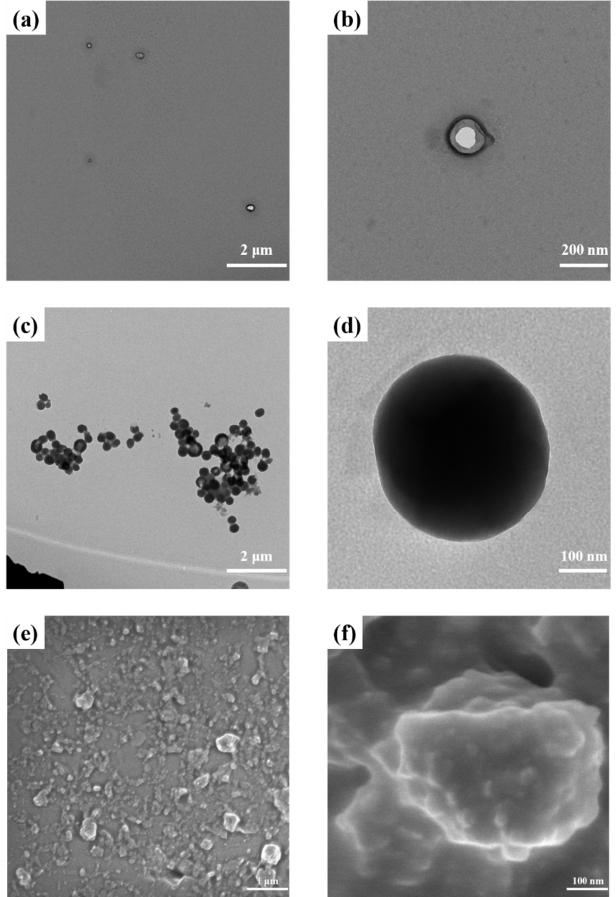
Figure 3. TEM and SEM images of the micelles: ( a ) TEM of PNI-U-DPy micelles; ( b ) TEM of PNI-U- DPy micelles (magnified); ( c ) TEM of PNI-C 60 micelles; ( d ) TEM of PNI-U-DPy micelles (magnified); ( e ) SEM of PNI-C 60 micelles; ( f ) SEM of PNI-C 60 micelles (magnified).